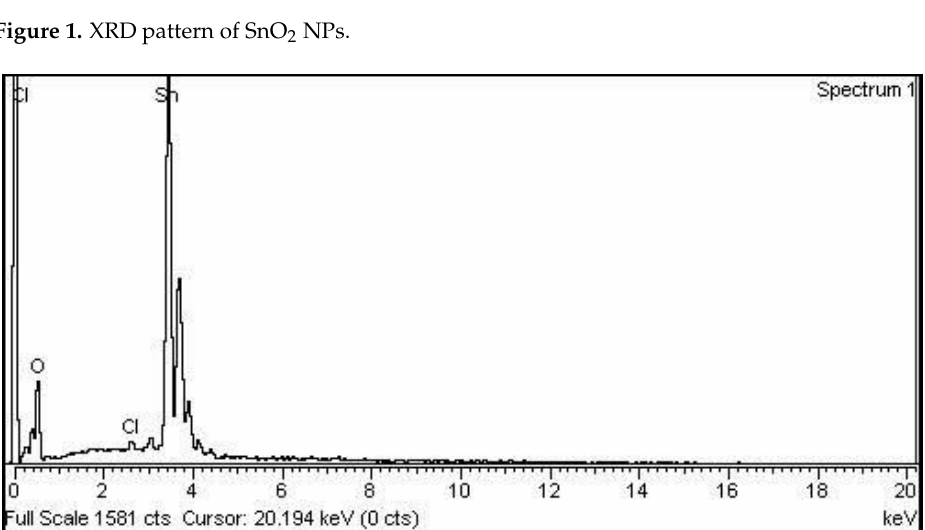
Figure 2. EDX pattern of SnO 2 NPs.